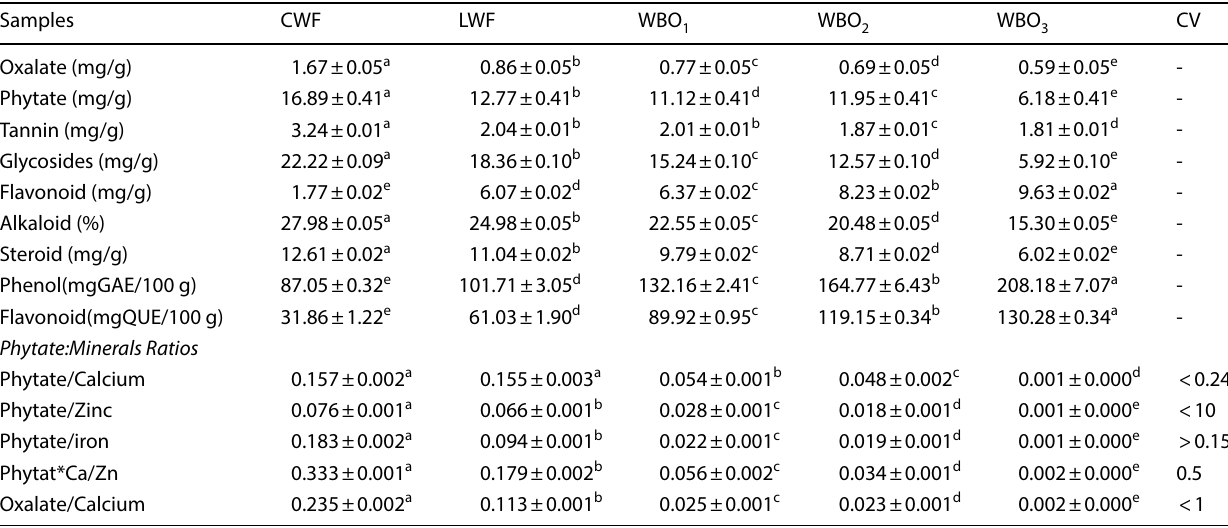
Table 3 Antinutritional composition of wheat-bambara groundnut bread samples